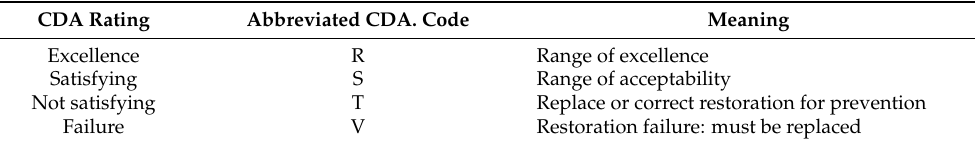
Table 1. Rating standardized parameters of the California Dental